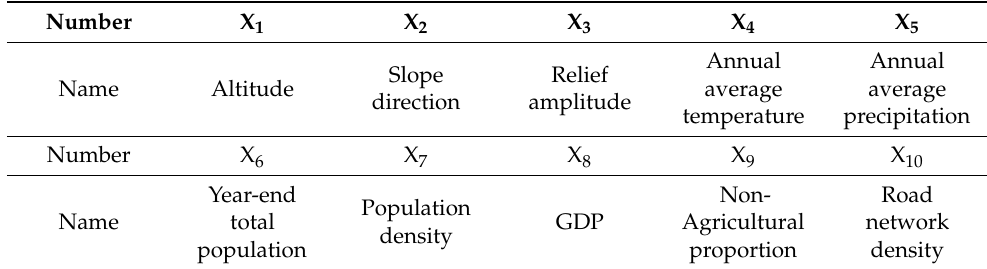
Table 3. The serial number and name of each